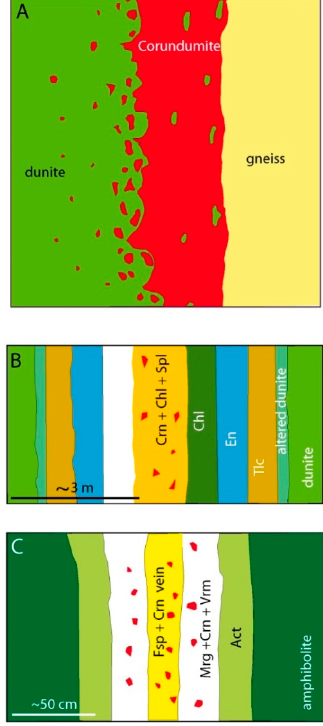
Figure 37. Metasomatic zoning in ruby-bearing metamorphosed dunites and amphibolites in the deposits of North Carolina, USA, modified from [195]. ( A ) The contact between dunite and gneiss is outlined by corundumite, Corundum Hill mine, Macon County. The scale is not qualitative; ( B ) ruby-bearing metasomatic zones in dunite at the Corundum Hill mine. The central part contains green chlorite (Chl) + ruby (Crn) + spinel (Spl) and the other zones are symmetrically disposed from this centre part. En = enstatite; Tlc = talcose rock; ( C ) ruby-bearing feldspar vein in amphibolite at Hunters, Iredell County. A metasomatic-metamorphic symmetrical zoning is developed around the vein. From the centre to the periphery: (1) a zone composed of vermiculite (Vrm)-bearing ruby with some margarite (Mrg) and (2) an actinolite (Act) zone at the contact with the amphibolite. (2) In Kenya, rubies were discovered in the Mangare area, Voi mining district, in 1973 by John Saul [183]. Mining in the John Saul mine (recently renamed the Rockland mine) provided a regular supply of either facet grade or cabochon rubies from 1993 to 2012. The John Saul, Penny Lane, and Hard Rock deposits occur in lenses of serpentinized ultramafic rock (UMR) bound by shear zones in a metasedimentary series composed of graphitic gneiss and felsic gneiss (Figure 38) [118]. Fe-poor ruby (FeO < 0.06 wt %) and pink corundum is located in (i) micaceous lenses and pockets along the contact of a shear zone with the metasomatized UMR. The ruby is associated with ± spinel ± sapphirine + mica or in some cases with phlogopite + Mg-chlorite; (ii) in plumasitic veins that crosscut